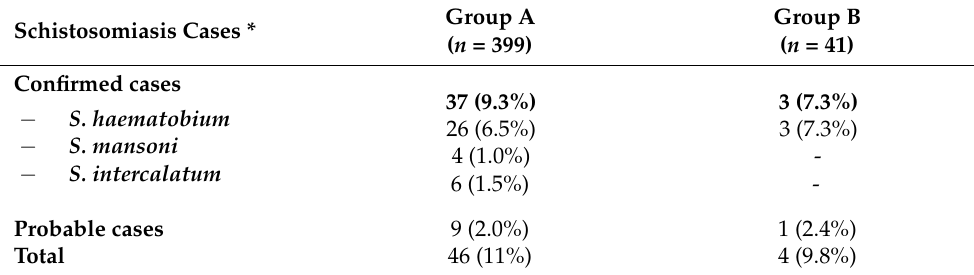
Table 2. Schistosomiasis cases diagnosed by screening strategy.